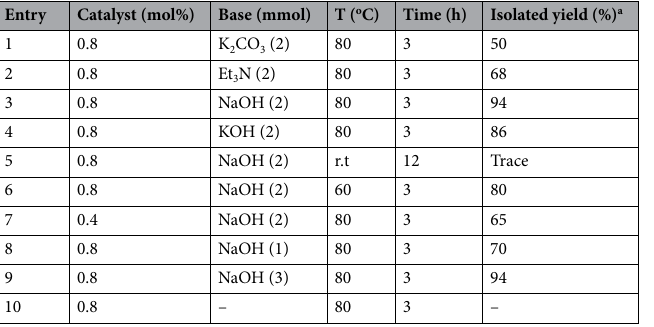
Table 1. Optimization reaction condition of Sonogashira coupling of iodobenzene and phenylacetylene catalyzed by